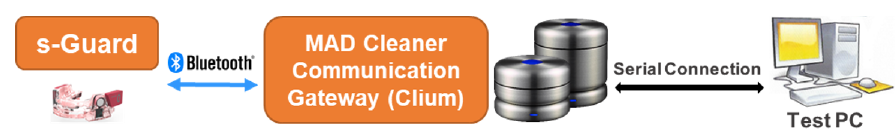
Figure 7. Experiment model of s-Guard Bluetooth communication performance.